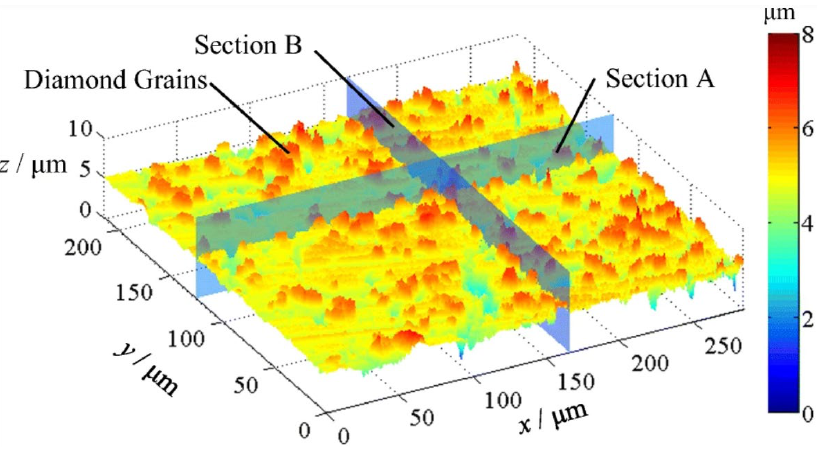
Figure 5. The micro-morphology of the surface of the diamond abrasive grinding wheel after dressing [11].